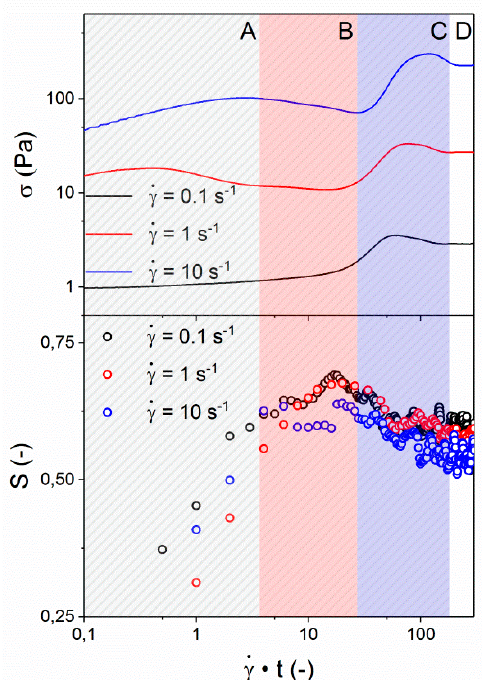
Figure 8. Response to inception of shear flow at 150 ◦ C for shear stress σ ( top ) and orientation parameter S ( bottom ). Please note, normalization of the x-axis has been performed to compare the shear behavior by plotting γ(cid:4662) ∙ t . The four characteristic regimes found during the inception of flow are marked in the figure.